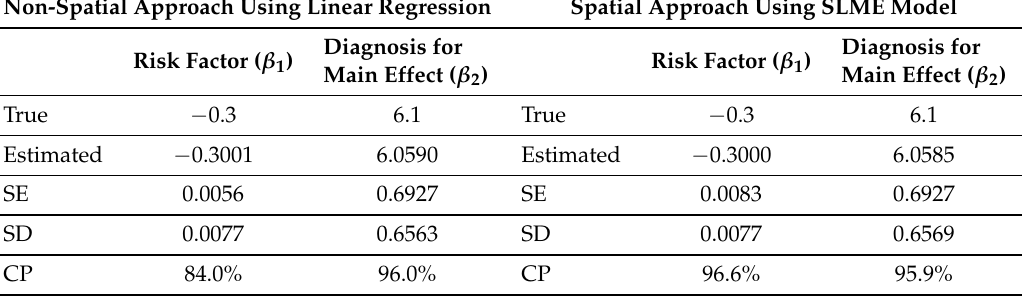
Table 8. Simulation studies: Scenario 2: moderate exponential spatial correlation between simulated spatial data ( γ e = 0.5, n = 200).